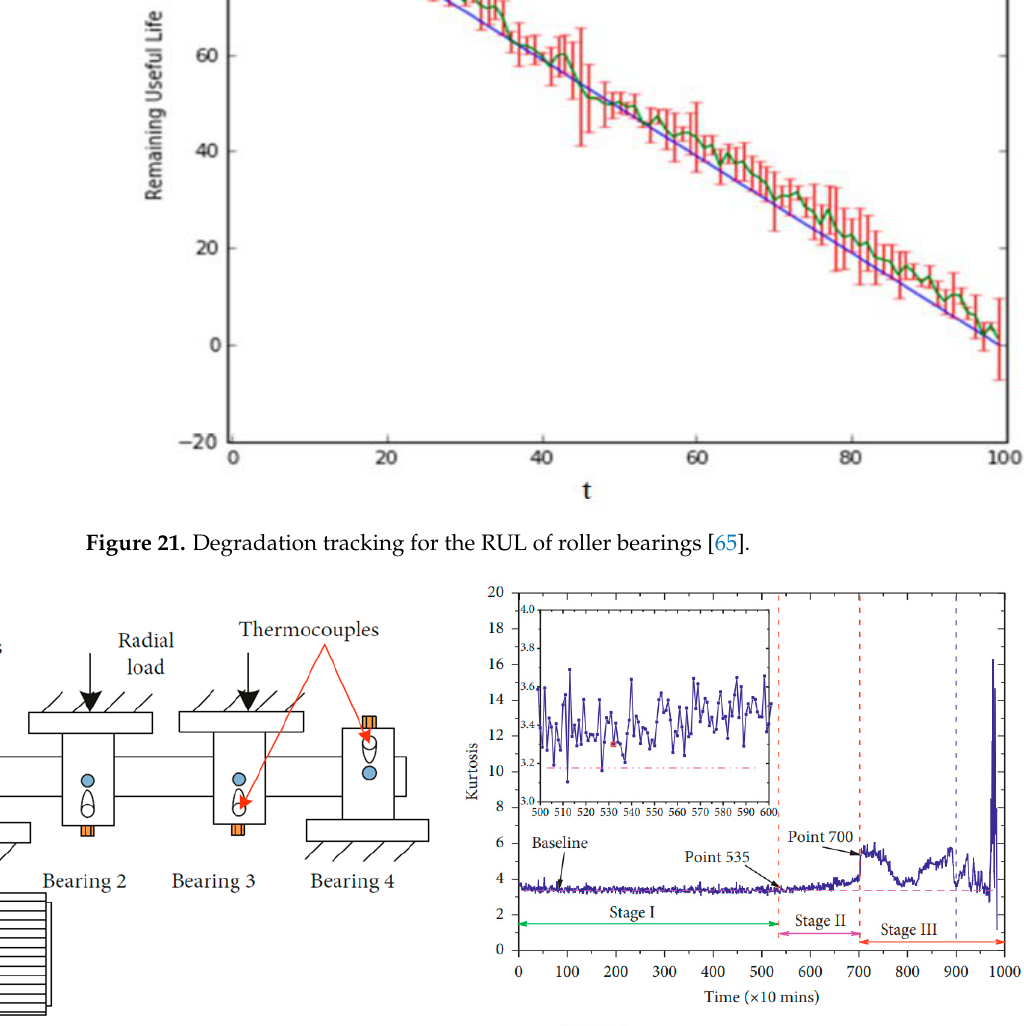
Figure 23. Ball bearing results based on EMD at ( a ) 0% loading conditions and ( b ) 100% loading conditions. Reproduced with permission of [67].